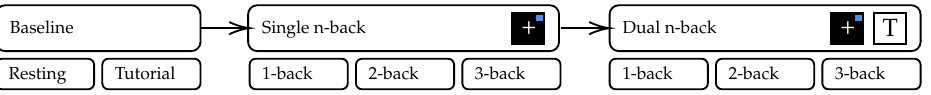
1,2, 3 are presented to the ∈ { }